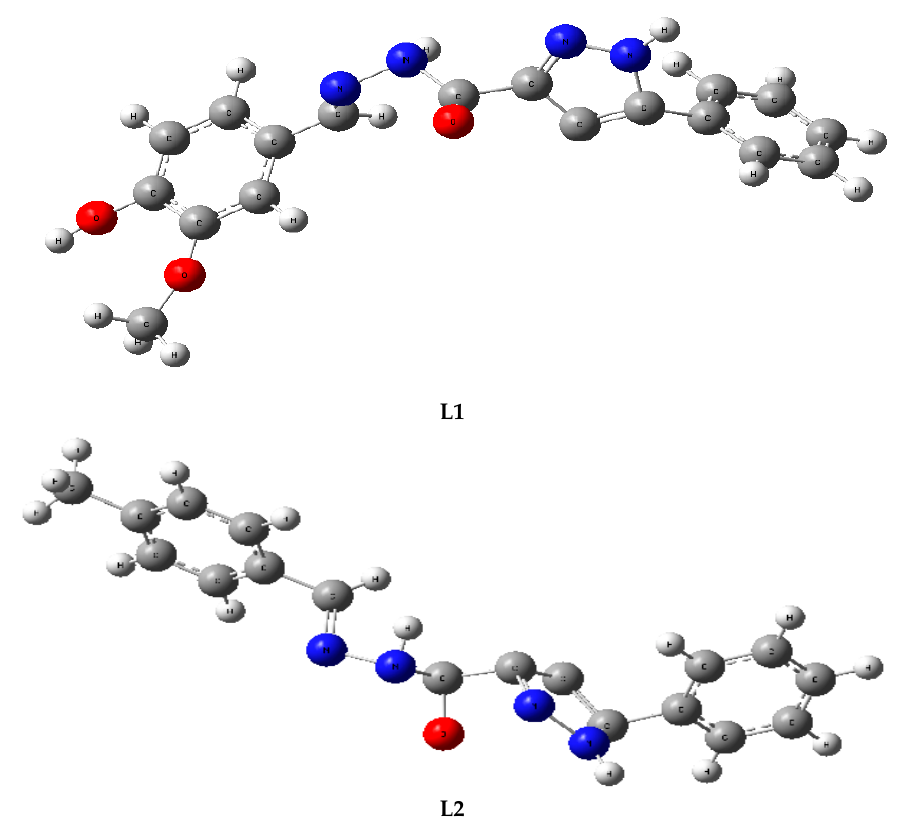
Figure 3. Optimized geometry of L1 and L2 . Table 2. Selected structural parameters by X-ray and theoretical calculations of compound L2